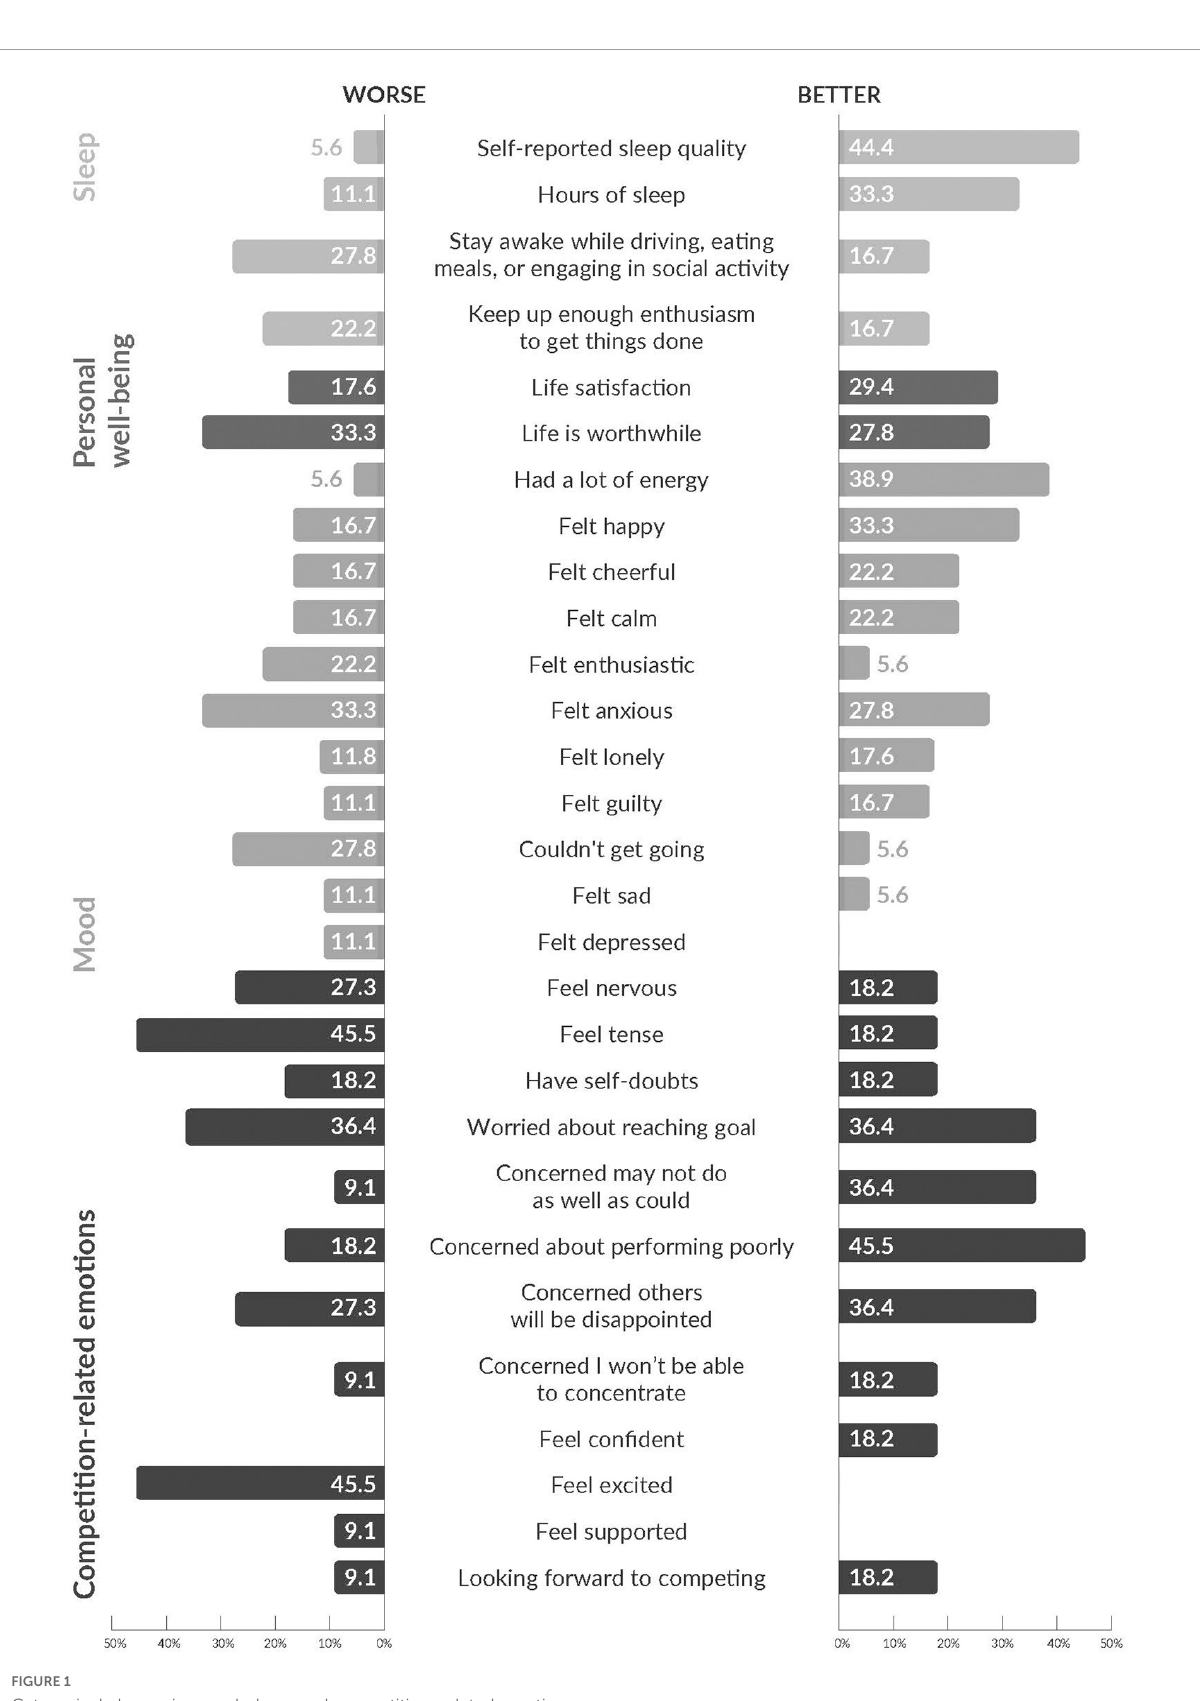
FIGURE1 Categorical change in mood, sleep, and competition-related